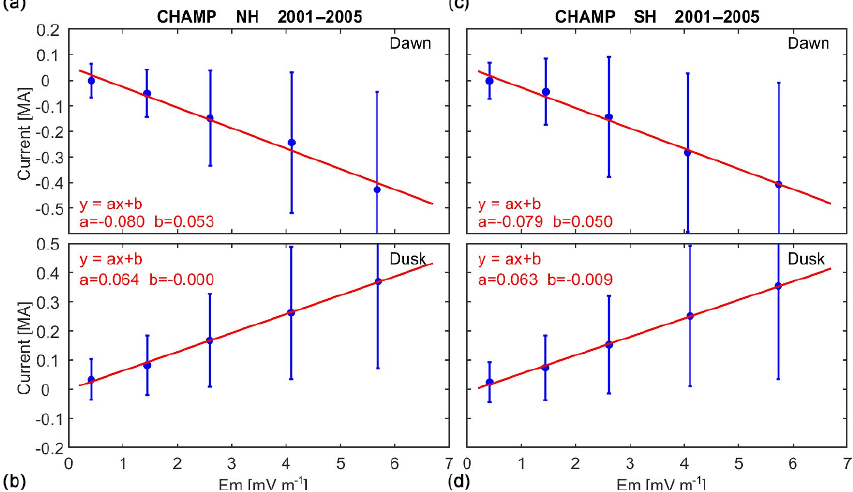
Figure 5. The merging electric field, E m , dependence of net currents on the dawnside and duskside, separately for the Northern Hemi- sphere (a, b) and Southern Hemisphere (c, d) . The solid dots with vertical bars indicate the mean values and standard deviation of the net eastward current for five levels of E m . Parameters of the linear fits (red lines) are listed in the top left corner of each frame.